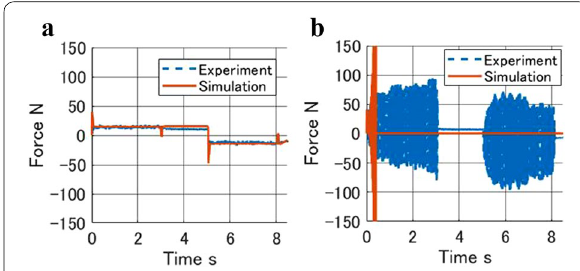
Fig. 12 Results of simulation and comparison with experimental results in control method 2. a Case2-1, b Case 2-2